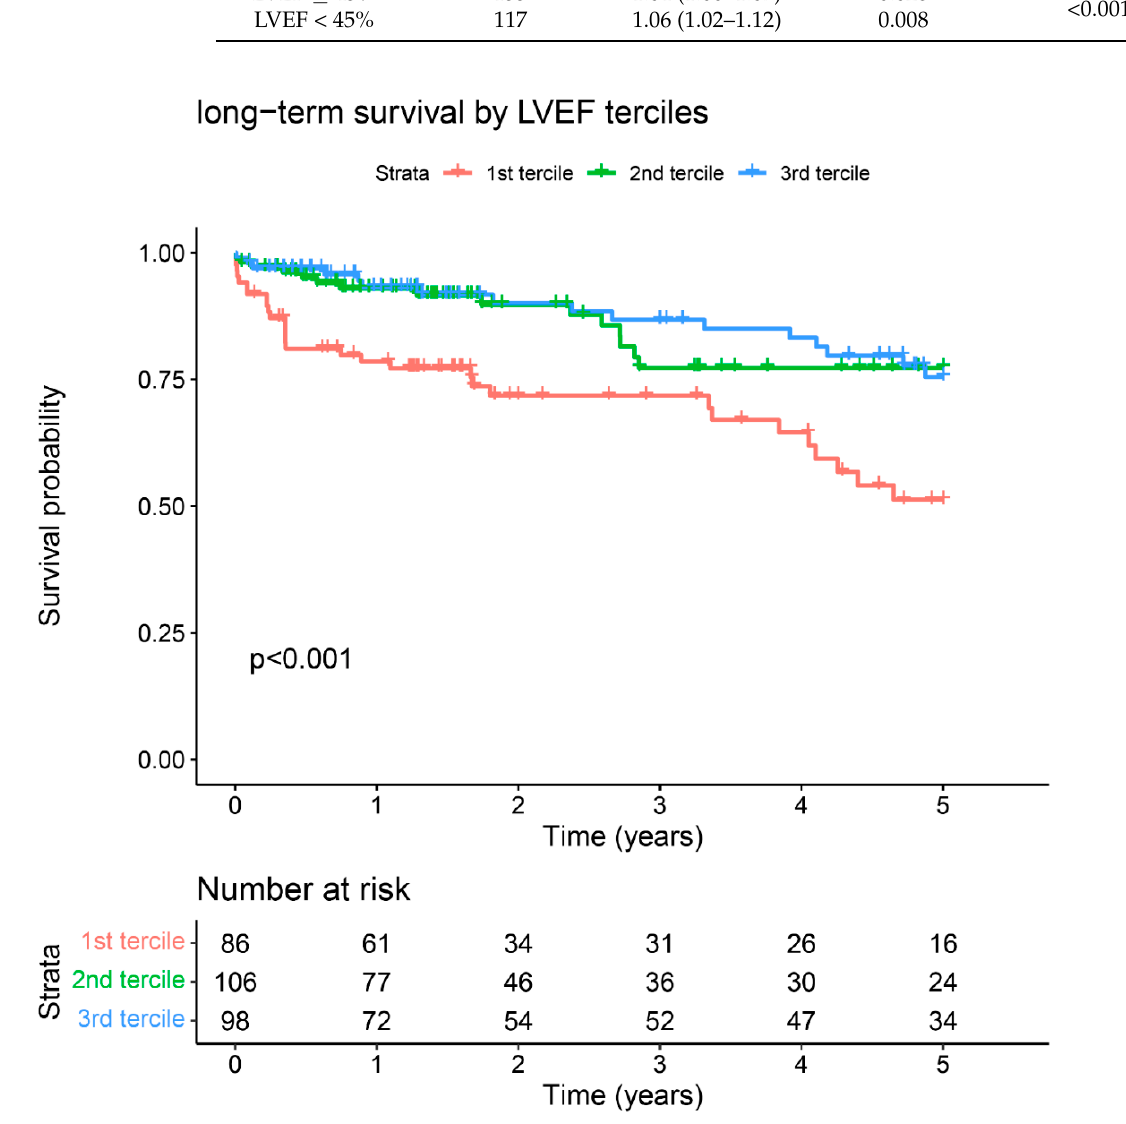
Figure A1 . Long-term survival stratified by LVEF terciles Figure A1. Long-term survival stratified by LVEF